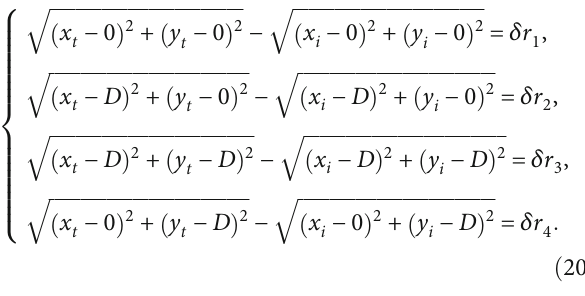
k and distribution of target function